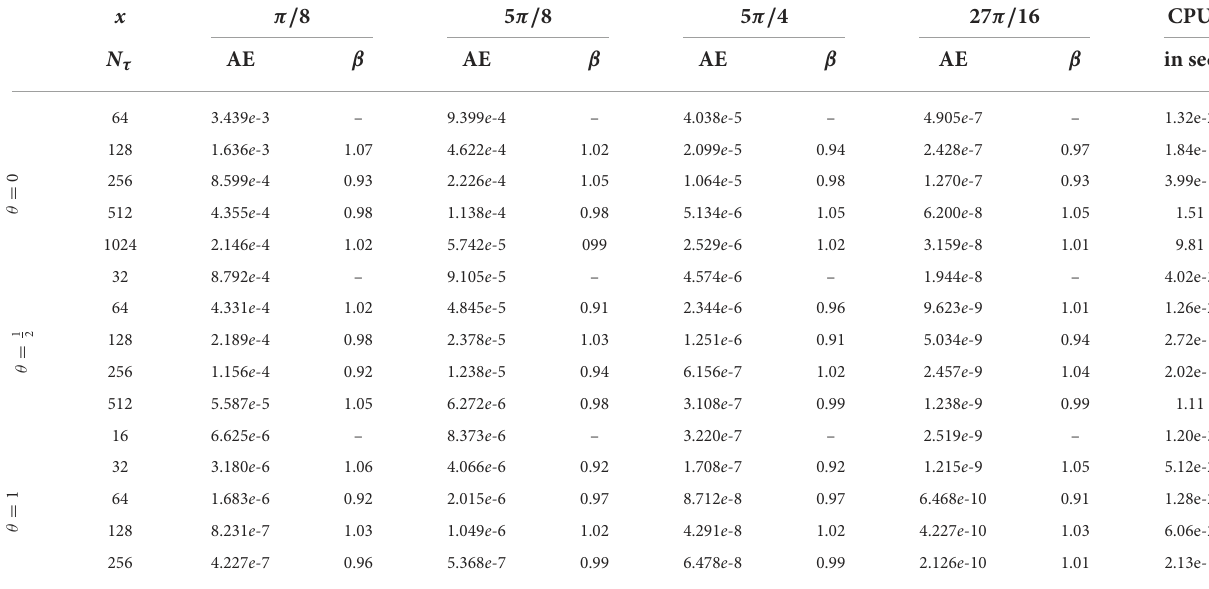
TABLE 3 Absolute errors, their convergence rates, and CPU time for several values of N τ , while N x = 16 of Example